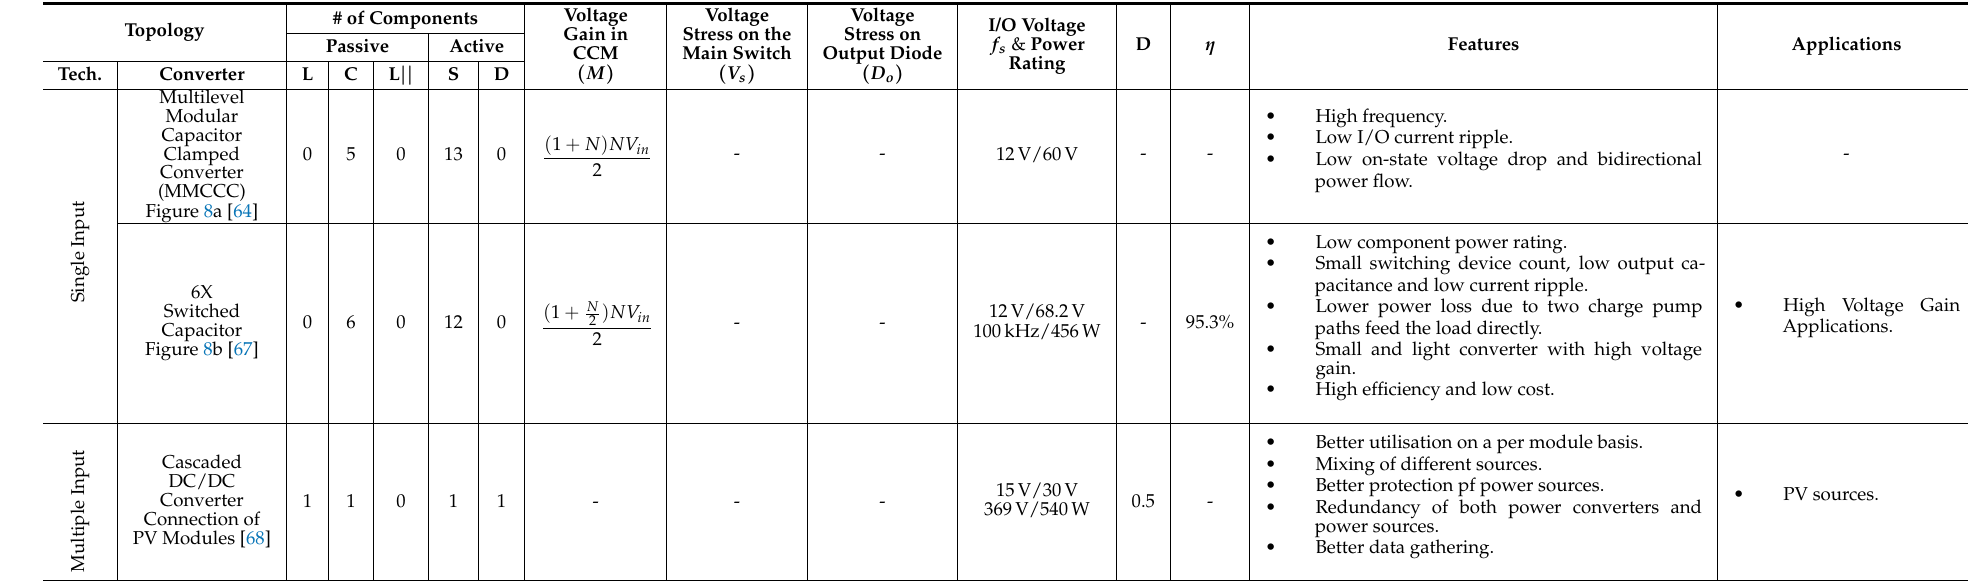
Table 4. Comparison of Multilevel Boost